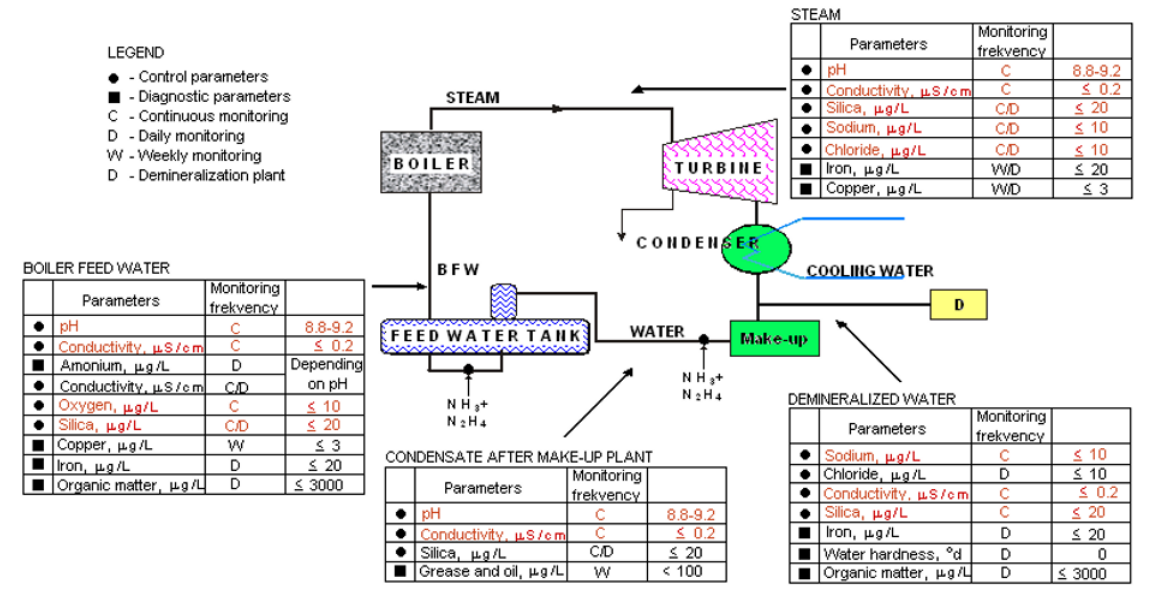
Figure 8. The design of an optimal monitoring with review of monitored parameters in the